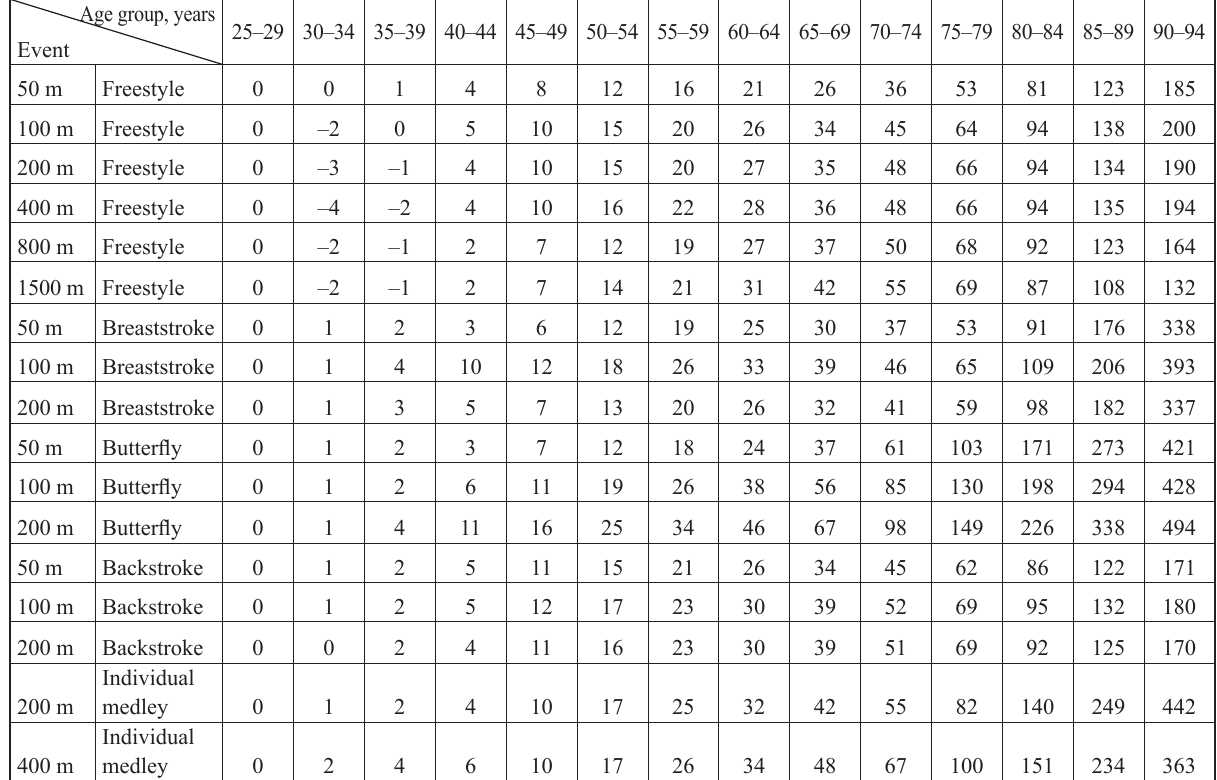
Table 1. Master swimmers’ (women) race time increase